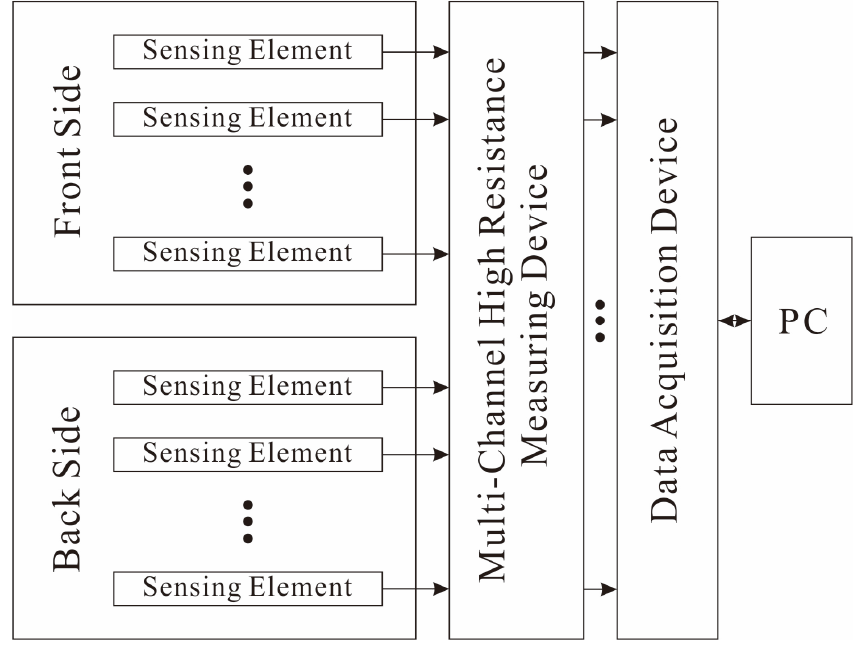
Figure 3. Diagram of the data acquisition system for the proposed sensor.